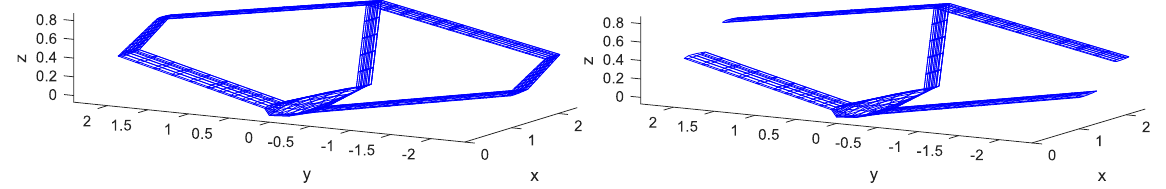
Figure 13. Box-wing configuration ( left ) and tandem-wing configuration ( right ) used for comparisons.